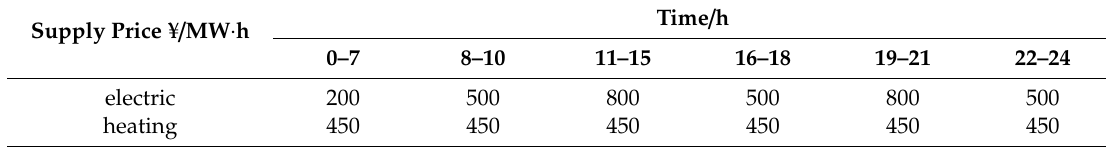
Table A2. The supply price of electric and heating.